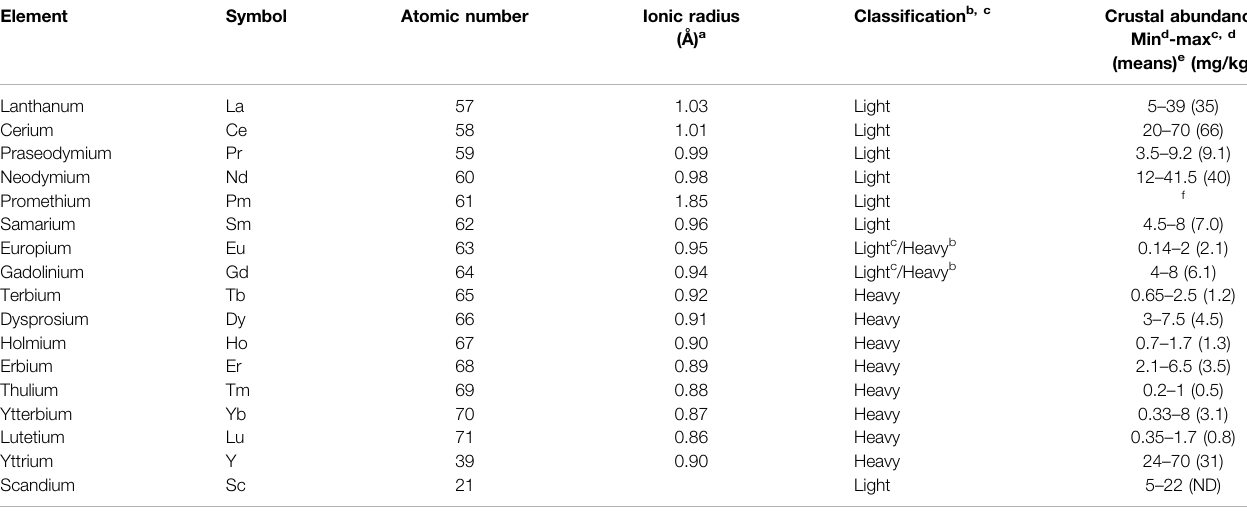
TABLE 2 | List of the rare earth (RE) found in natural deposits, classi fi cation and their abundance in the earth ’ s crust [in parts per million (mg/kg)].